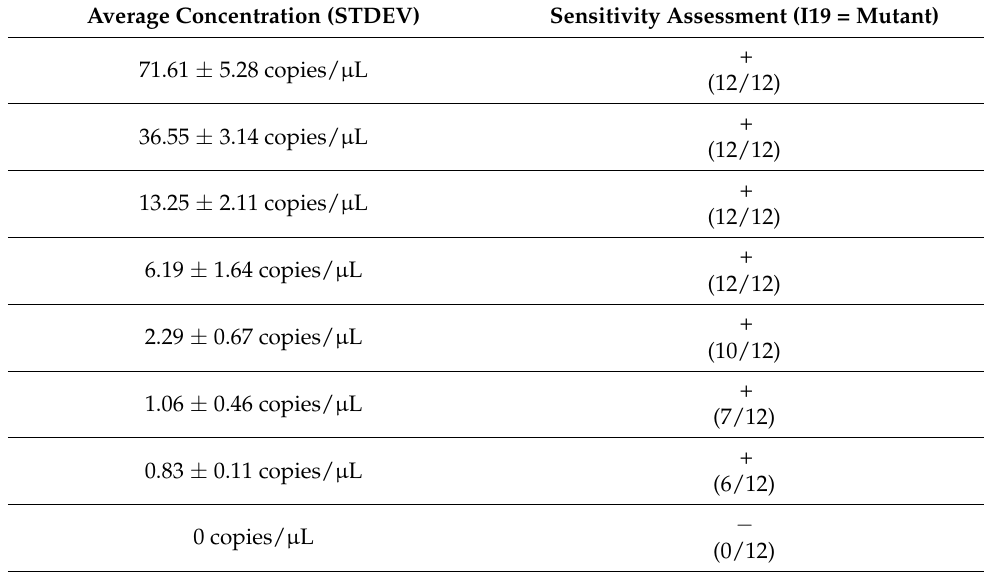
Table 4. Sensitivity assessment of the I19 mutant probe using the SARS-CoV-2 BA.2 variant control. The absence or presence of amplification is indicated by − or +, respectively. For each average concentration ( ± the standard deviation), 12 replicates were tested, and the number of positive replicates is indicated between brackets at the middle line of each